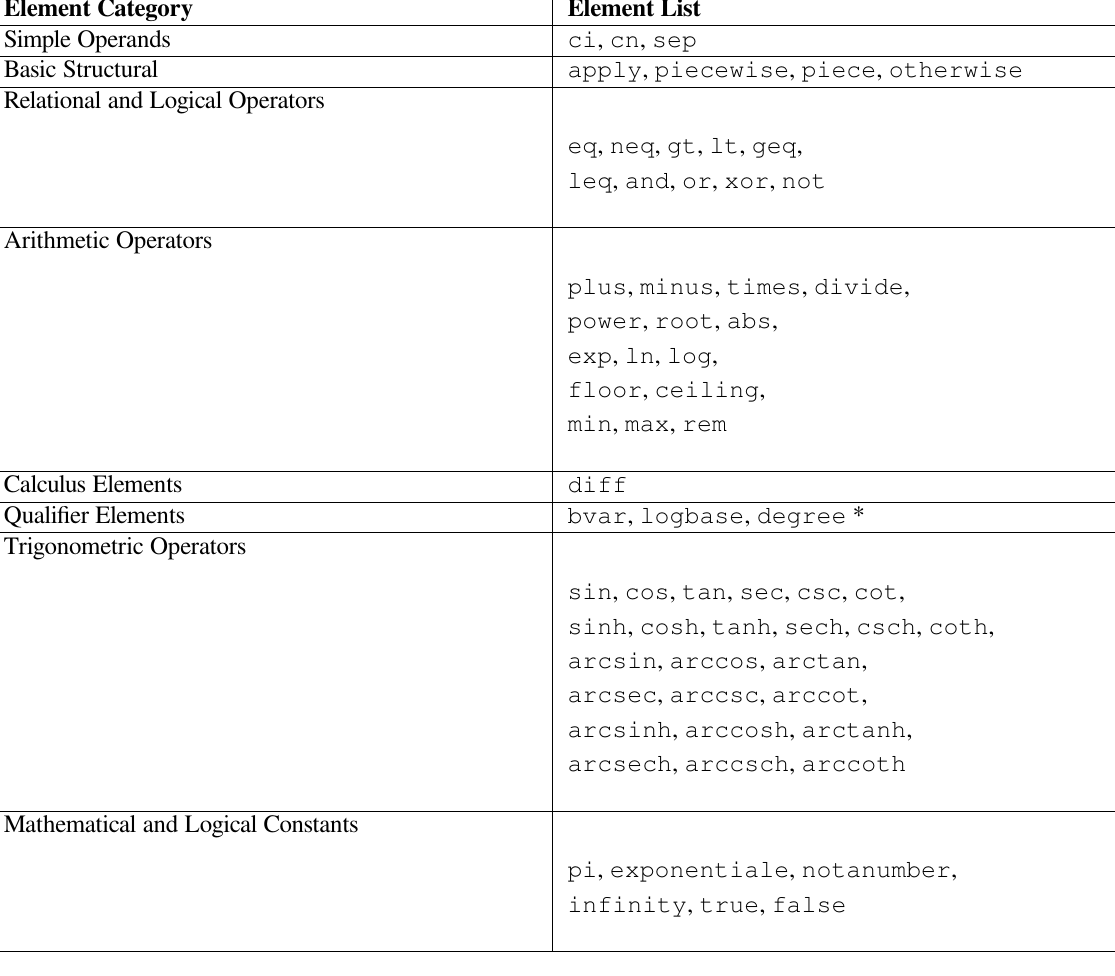
Table 2.1: Supported MathML